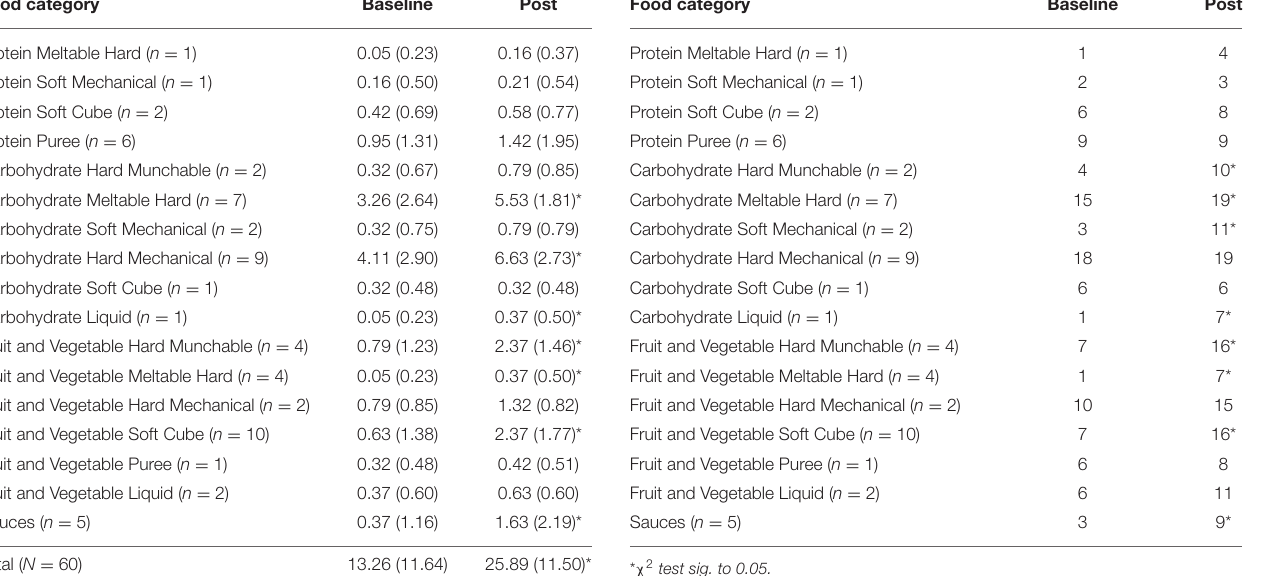
TABLE 3 | Mean (SD) number of foods tried by pupils at Baseline and Post intervention across food categories. Food